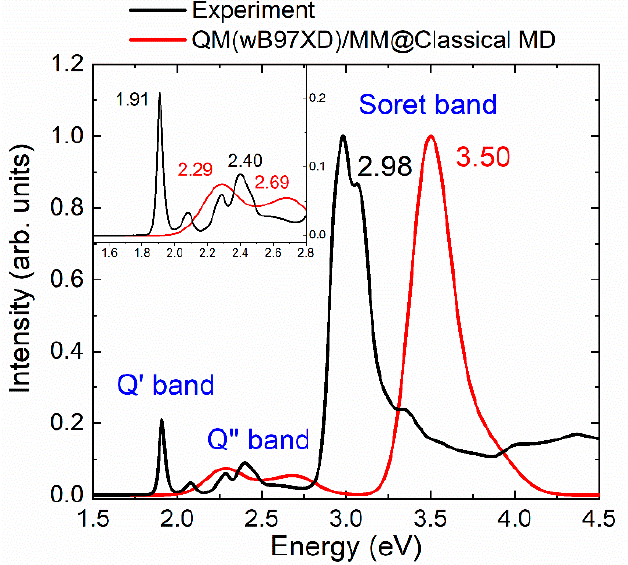
Figure 1. Comparison of the QM(wB97XD)/MM@Classical-MD spectrum (red curve) and the experimental spectrum (black), scaled with respect to the Soret band. In the inset a zoom on the Q-bands with the corresponding energy values at the maxima in eV is reported.